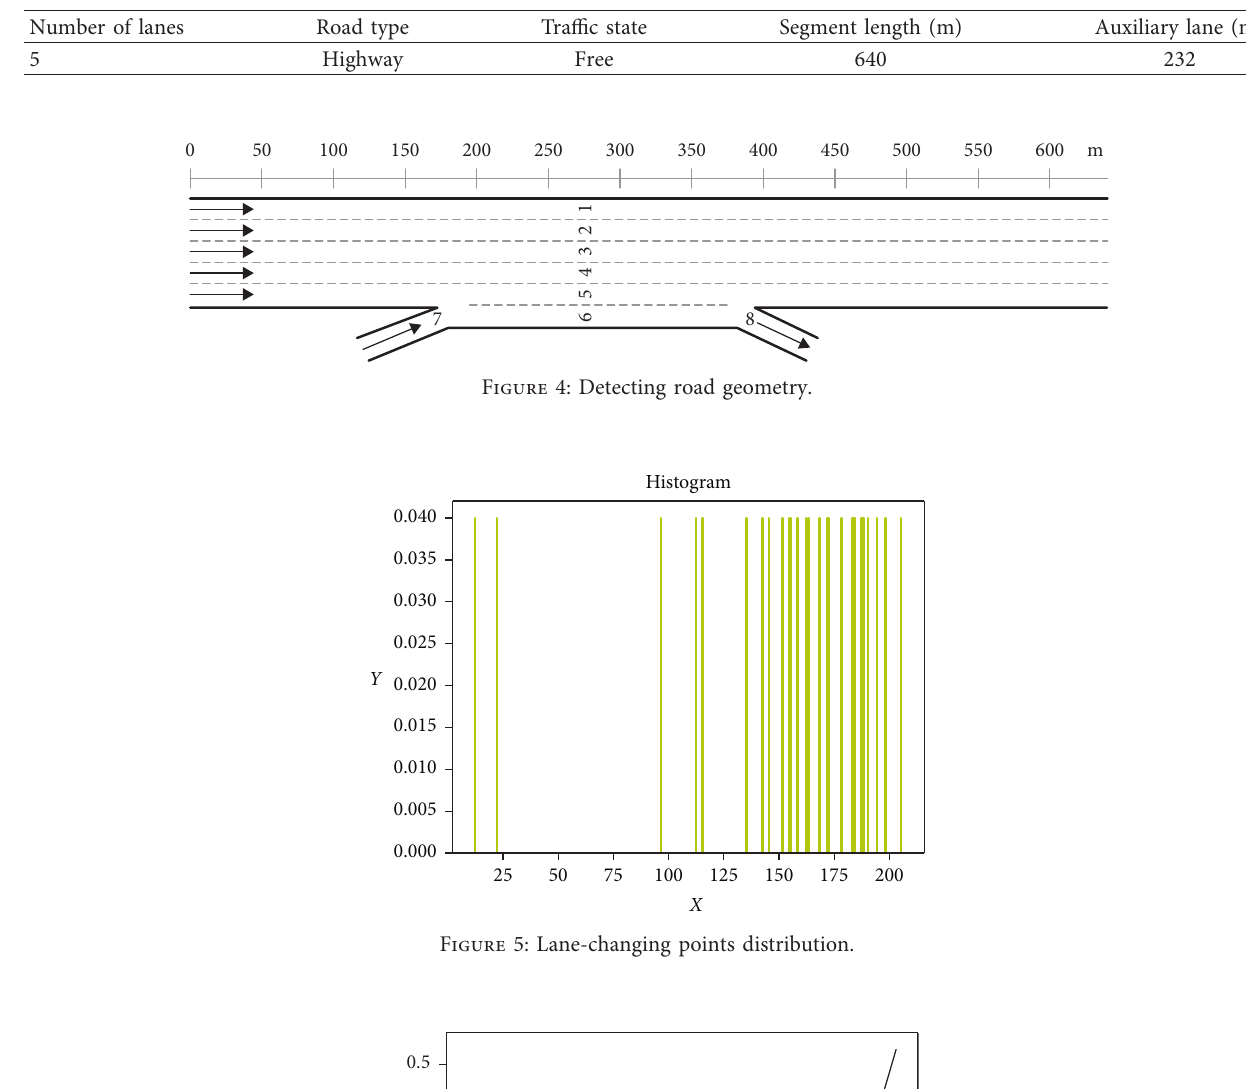
Table 1: Detecting road parameters.